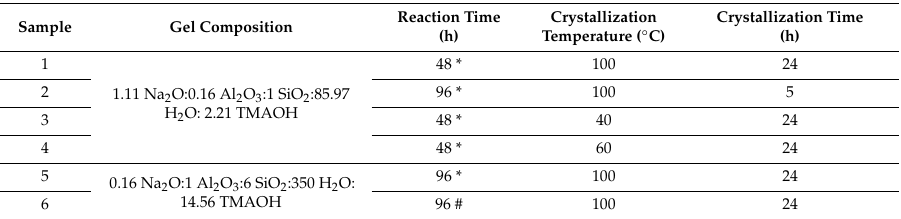
Table 1. The gel compositions and conditions of NaA nanozeolite synthesis. (* aging process at room temperature, # aging process at a temperature of an ice